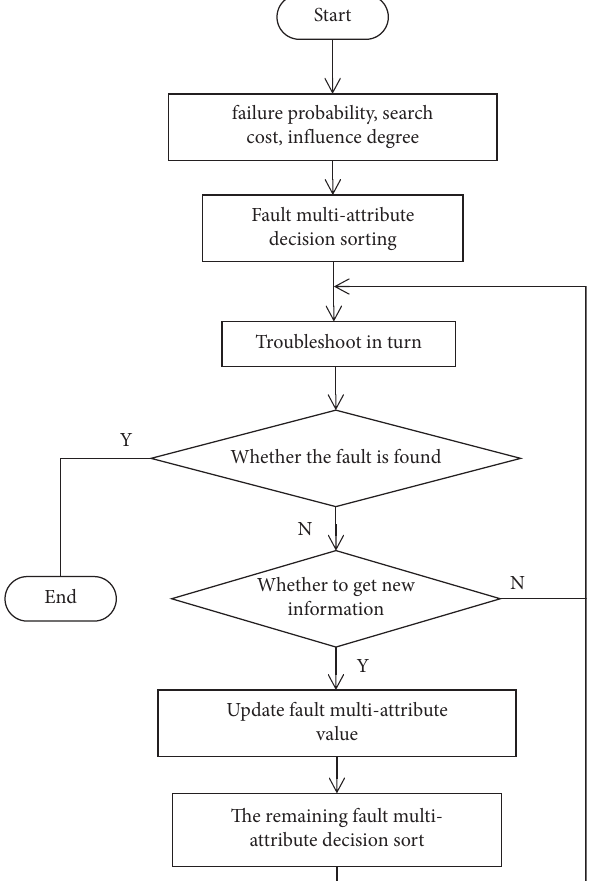
Figure 4: Multiattribute fault location fused with dynamic